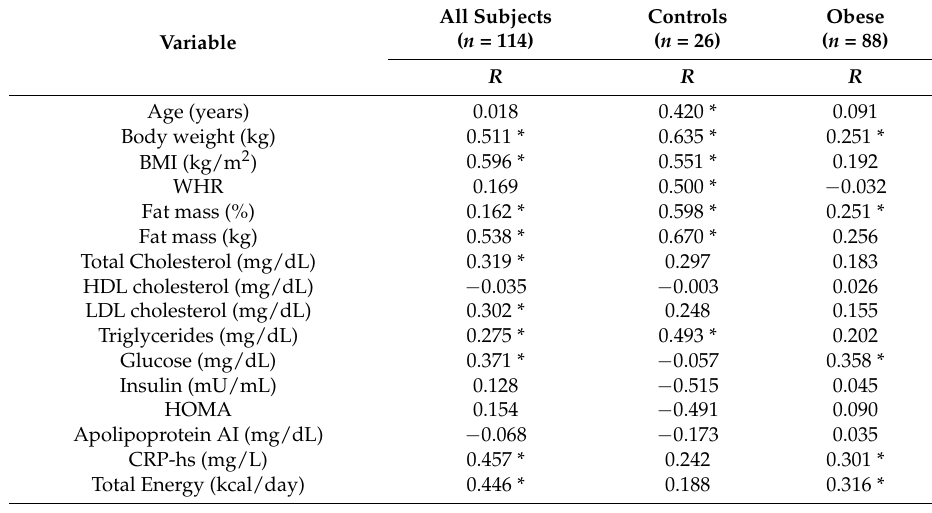
Table 3. Spearman correlations between DNA damage (% DNA in tail), biochemical and anthropometric parameters, and dietary